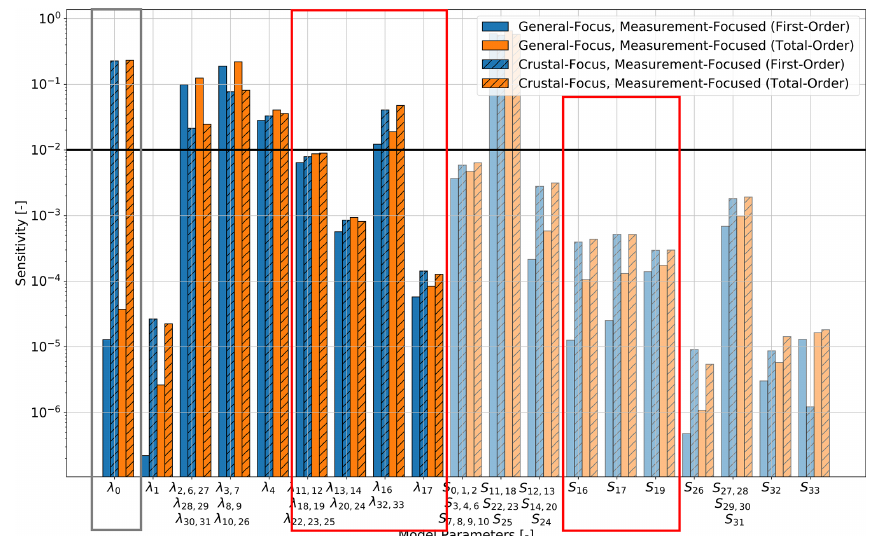
Figure 16. Comparison of the sensitivities of the measurement-focused study for both the General-Focus and Crustal-Focus Alps model. The solid black line denotes the threshold value for determining if the parameters are influencing the model response.